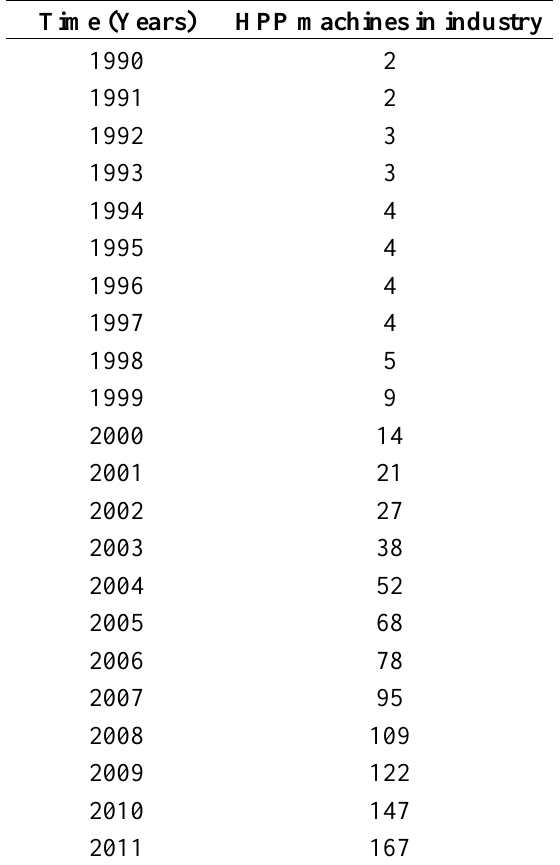
Table 1. Number of HHP machines around the world. Source: Hiperbaric, S.A. [3]. Time (Years) HPP machines in industry